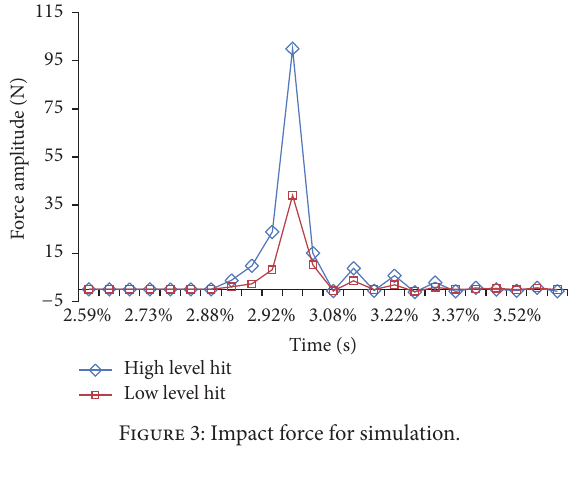
Figure5:Thecomparisonoffrequencyresponsecurvesfordifferent excitation amplitudes.